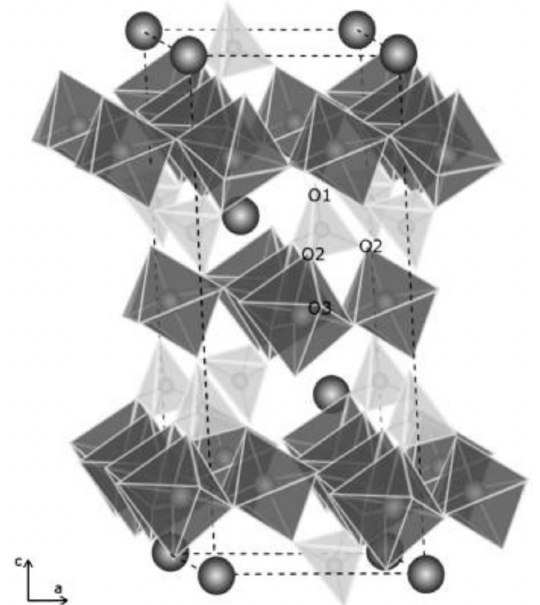
Figure 2. Scheme of the natroalunite structure, equivalent to the jarosite structure